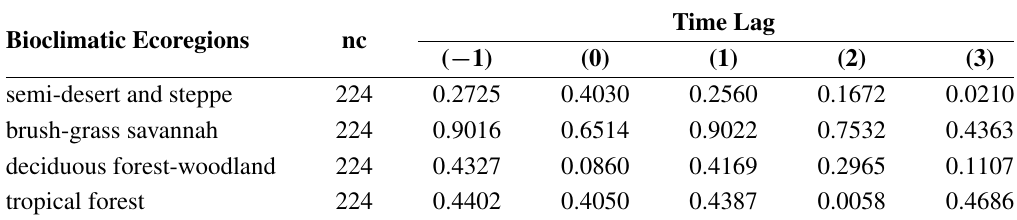
Correlation between monthly NDVI and rainfall in various intervals for four bioclimatic ecoregion (BCER) zones. The parameter, nc, is the number of correlation